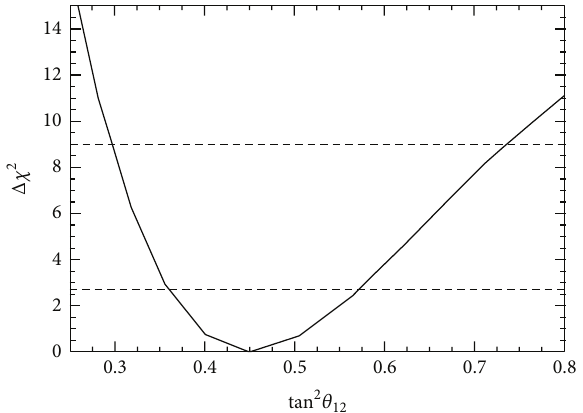
Figure 9: Dependence of 𝜒 2 on the free parameter 𝜆 2 . Dotted lines indicate 90 % and 99.73 % confidence levels.